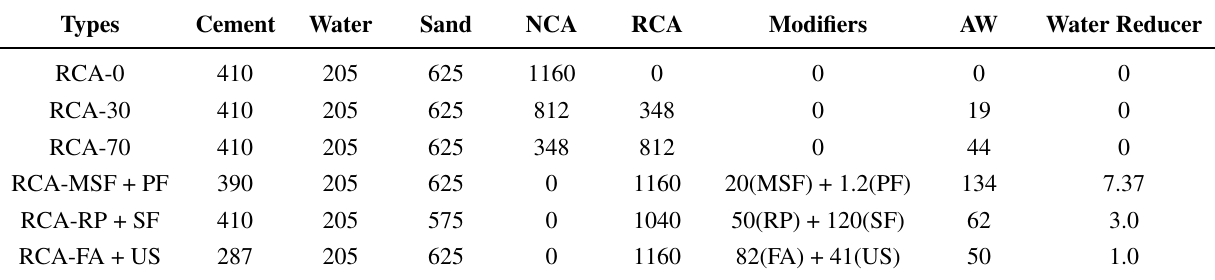
Table 5. Mixture proportions of recycled aggregate concretes (kg/m 3